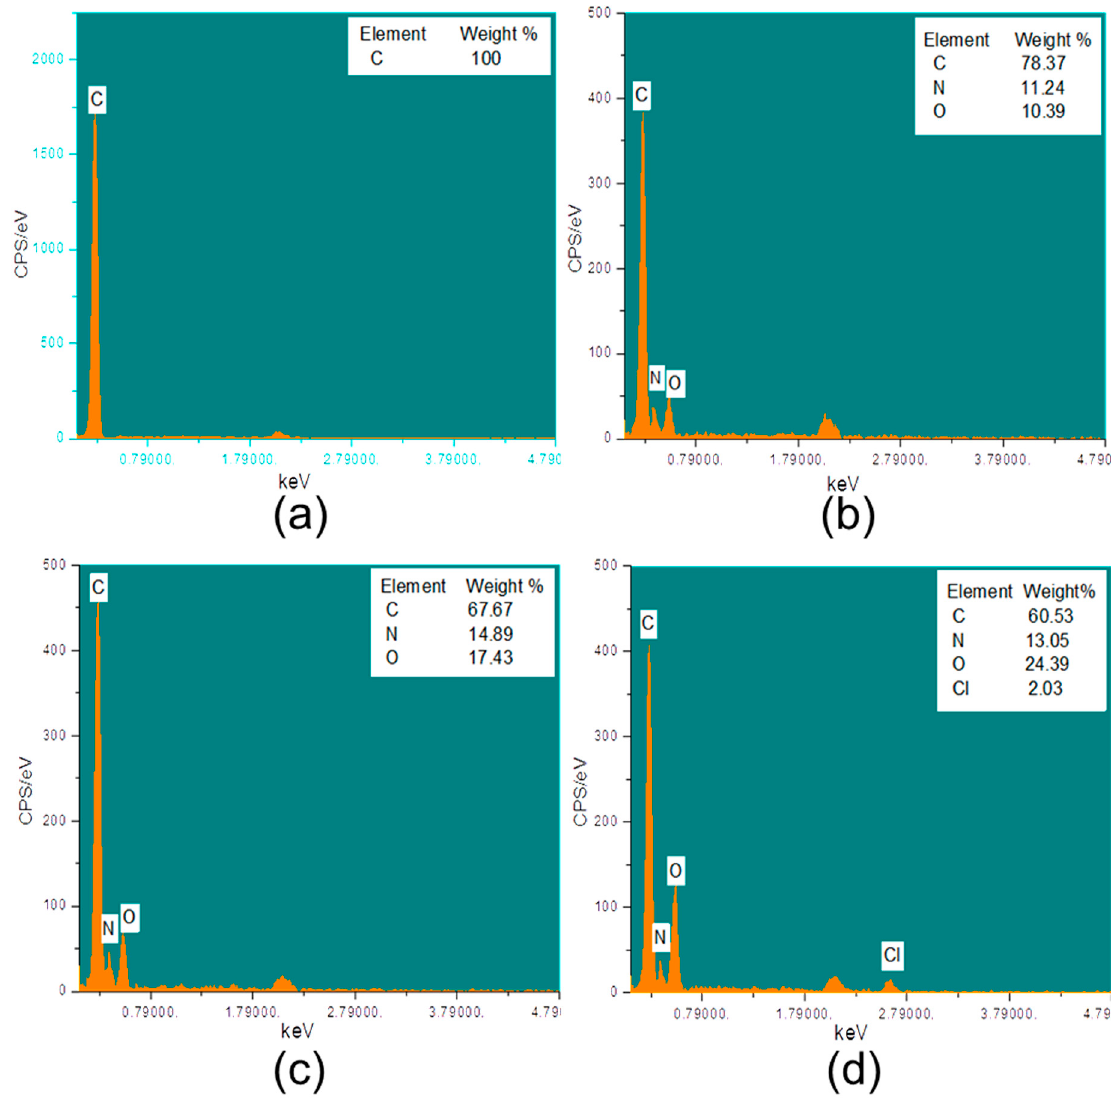
Figure 4. EDX spectra and atomic percent of PP control and modified meshes ( a ) PP control; ( b ) HDI grafted, PP-HDI-6; ( c ) HDI-CD-6; ( d ) CD-TCL-6.